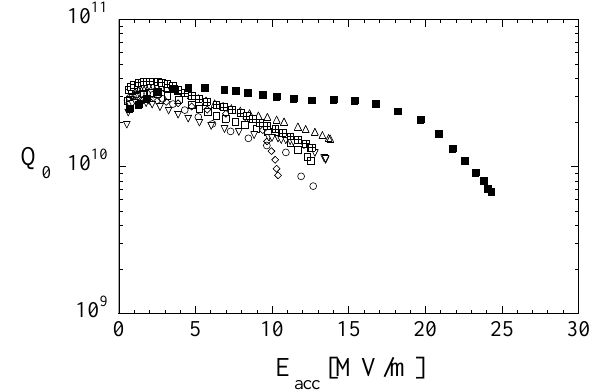
FIG. 17. Excitation curves of six cavities with imperfect equa- tor welds (class 3). Also shown is a resonator ( (cid:3) ) made later by the same company, following stringent cleaning procedures at the equator